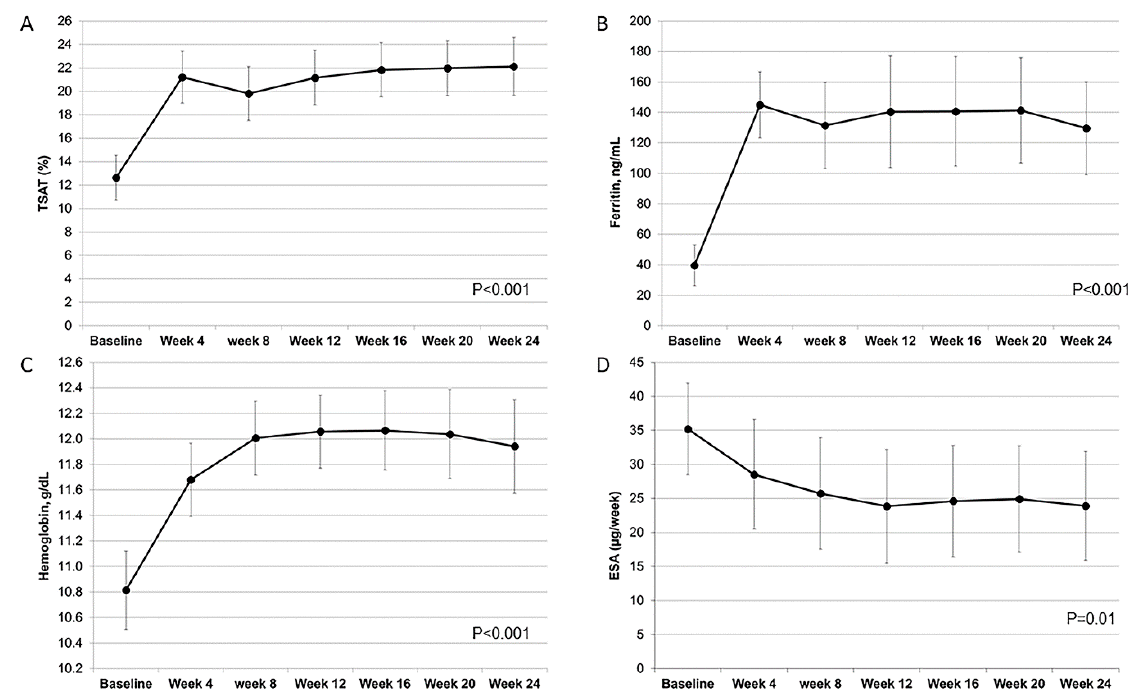
Figure 1. Changes of transferrin saturation (TSAT, Panel ( A )), ferritin (Panel ( B )), hemoglobin (Panel ( C )) and ESA dose (Panel ( D )) during the study. Table 4. Increase of TSAT, ferritin and hemoglobin from baseline to evaluation period (week 20–24) in the whole cohort and after stratification by either clinical setting or ESA